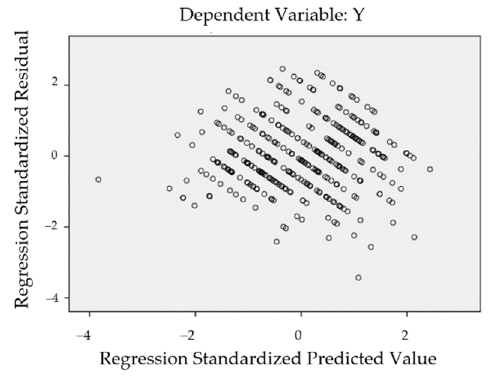
Figure 10. Scatterplot. Figure 10.